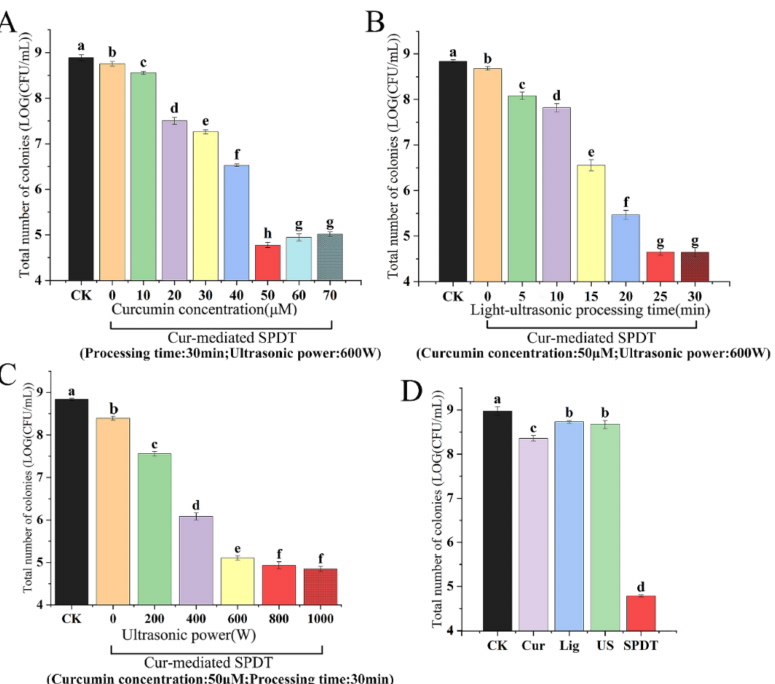
Figure 2. The optimization of curcumin concentration ( A ), light-ultrasonic processing time ( B ) and ultrasonic power ( C ) for the bactericidal activity of curcumin-mediated sono-photodynamic treatment against Listeria monocytogenes ; ( D ) The bactericidal effects of curcumin only (50 µ M), light-illumination only (25 min), ultrasonic treatment only (800 W) and curcumin-mediated SPDT against LMO . CK: Control group without treatment; Cur: Curcumin-treated group; Lig: Light-illuminated group; US: Ultrasound-treated group; SPDT: Curcumin-mediated sono-photodynamic treated group. The significant differences among samples were denoted by various lowercase letters ( p < 0.05).